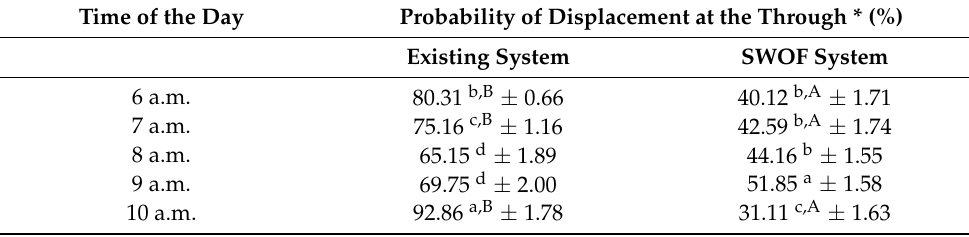
Table 9. Probability of displacements at the trough while feeding in the existing and SWOF systems (in %; back-transformed LSM ± SE).